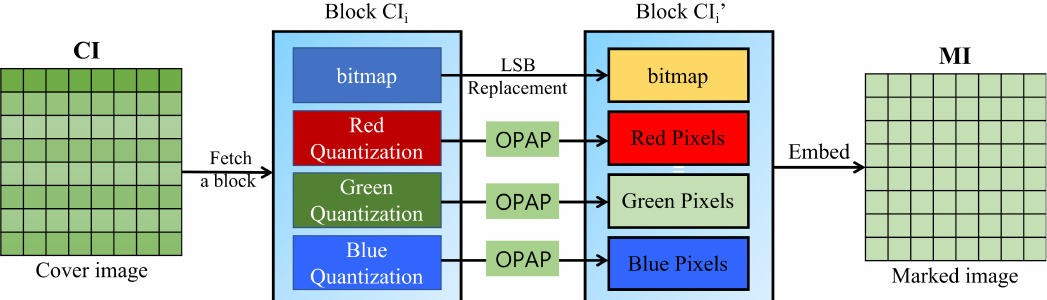
Figure 3. Schematic diagram of DH